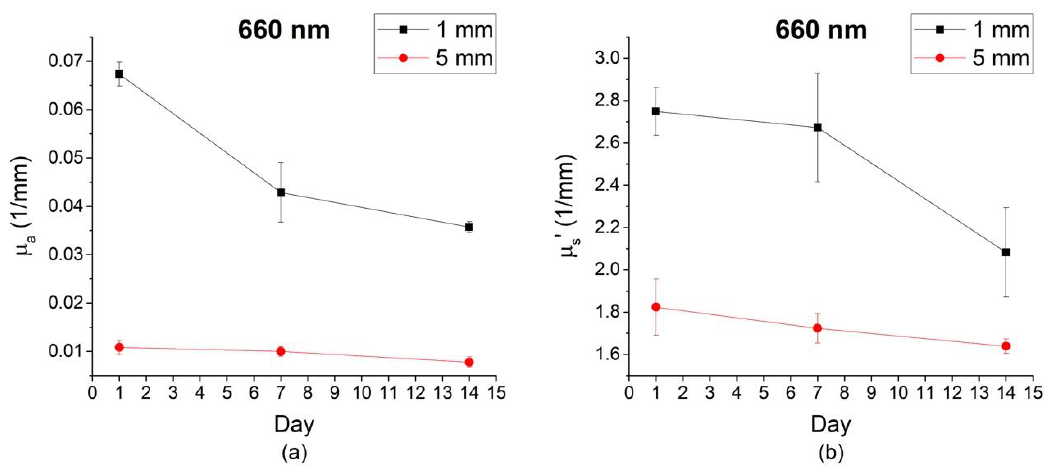
Figure 5. ( a ) Absorption and ( b ) reduced scattering coefficients of an apple recovered at source– detection separation (SDS) of 1 mm (black squares) and 5 mm (red circles) 1, 7, and 14 days after purchase at a wavelength of 660 nm.